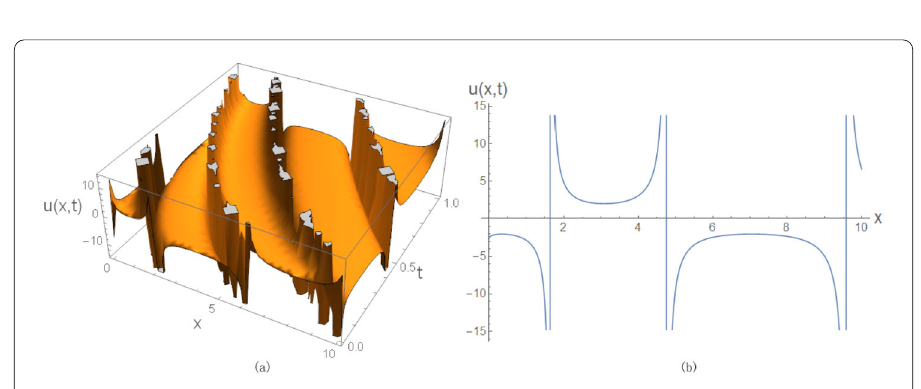
Figure 5 ( a ) Three-dimensional figure of (48), when κ = 1, c = – 7 two-dimensional figure when t = 0.5